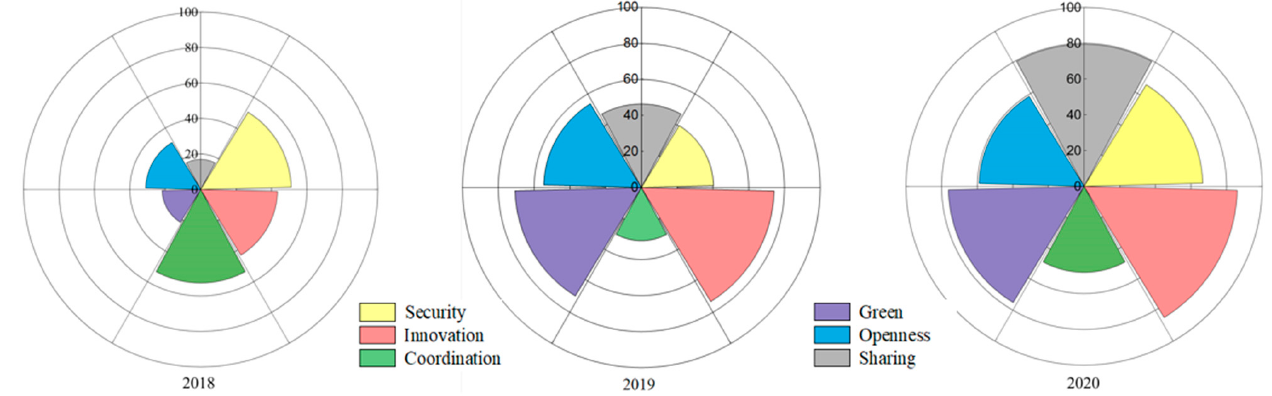
Figure 4. Changes in the six dimensions of the city health index in Xining from 2018 to 2020.